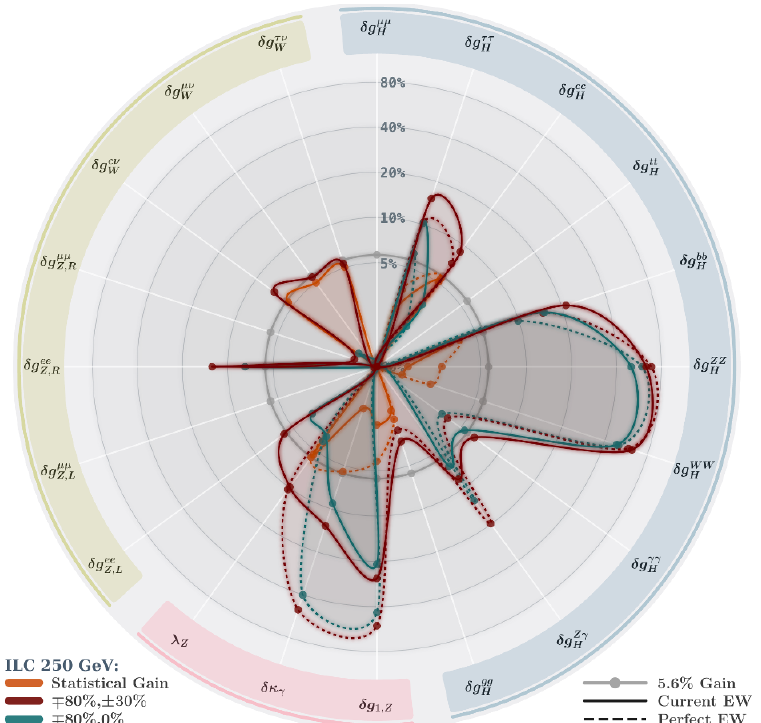
Figure 8 . Strengthening in global constraints arising from the introduction of P ( e (cid:0) ; e + ) = ( (cid:7) 80% ; (cid:6) 30%) and ( (cid:7) 80% ; 0%) beam polarizations at a centre-of-mass energy of 250 GeV (in red and green, respectively) quanti(cid:12)ed as (cid:14)g (unpolarized) =(cid:14)g (polarized) (cid:0) 1 expressed in percent. For comparison, the improvement of constraints brought by a factor 1 : 12 increase in luminosity in shown in orange. This factor is the purely statistical gain on e + e (cid:0) ! hZ and e + e (cid:0) ! (cid:23)(cid:23)h rate incurred with ( (cid:7) 80% ; (cid:6) 30%) beam polarization. The grey band is representative of a 5.6% gain p ( 1 : 24 (cid:2) 0 : 9 (cid:0) 1). The numerical inputs for P ( e (cid:0) ; e + ) = ( (cid:7) 80% ; (cid:6) 30%) and unpolarized beams are taken from table